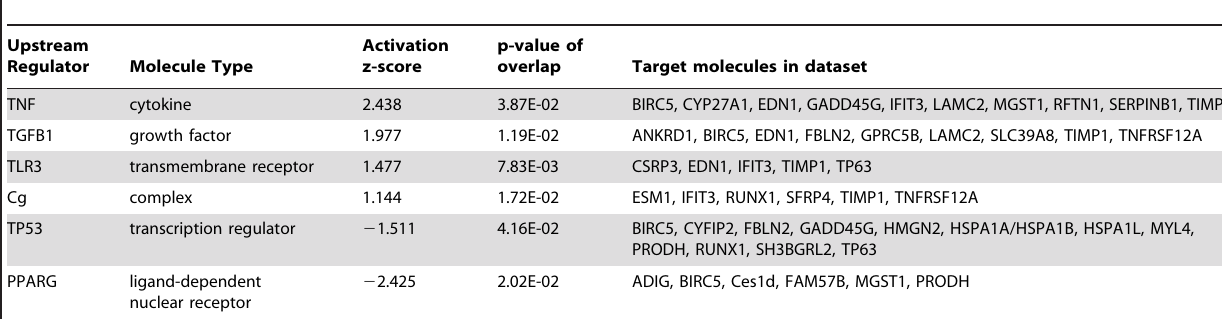
Table 2. Upstream analysis by IPA of altered genes of young and old TauTKO muscles.